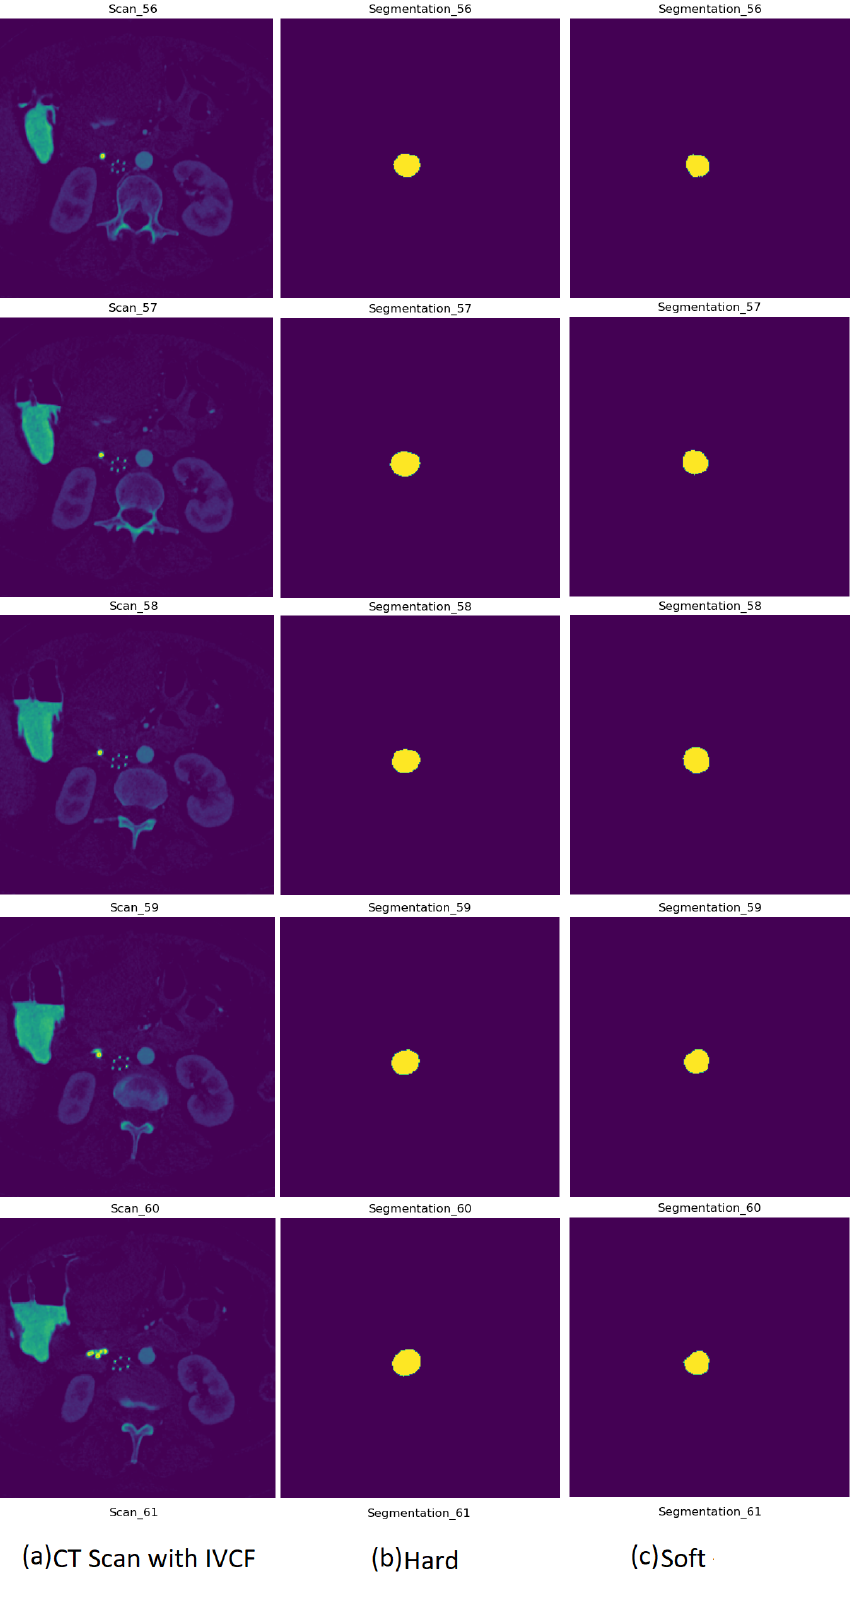
Figure 8. Segmentation output from UNet model variants on a CT scan using hard normalized